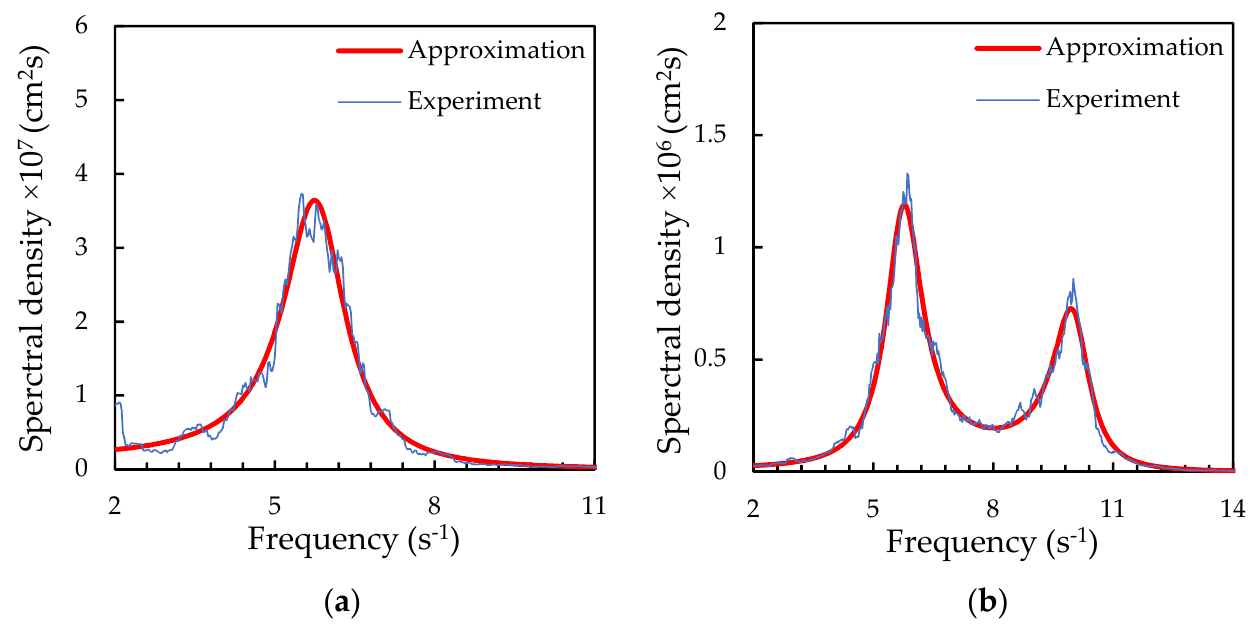
Figure 2. Spectral density of horizontal oscillations of ( a ) the solitary particle and ( b ) the lower particle in the system of two vertically aligned particles. The thin line shows the experimental data obtained for 1.05 mA, and the bold line plots the fit by the analytical function [27].